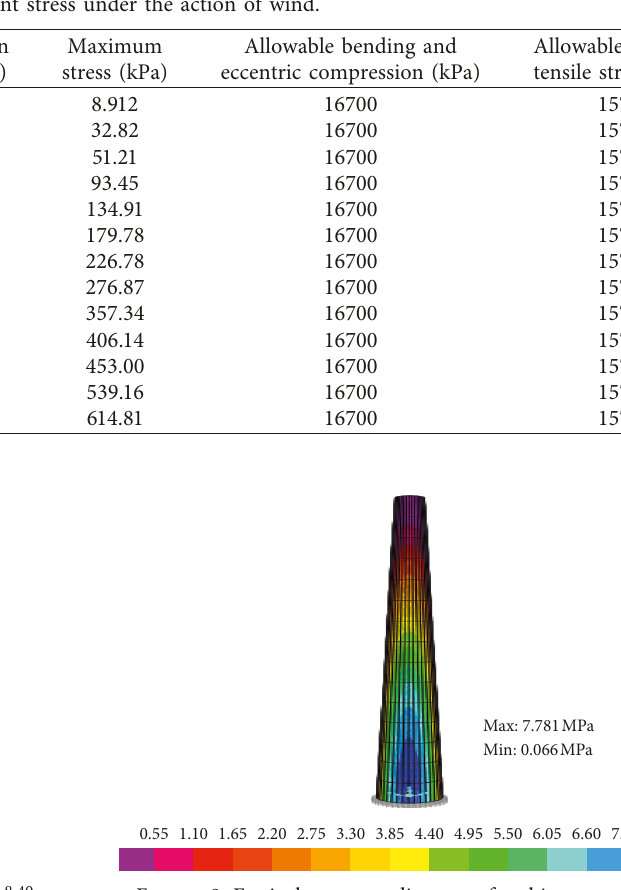
Figure 8: Equivalent stress diagram of a chimney at